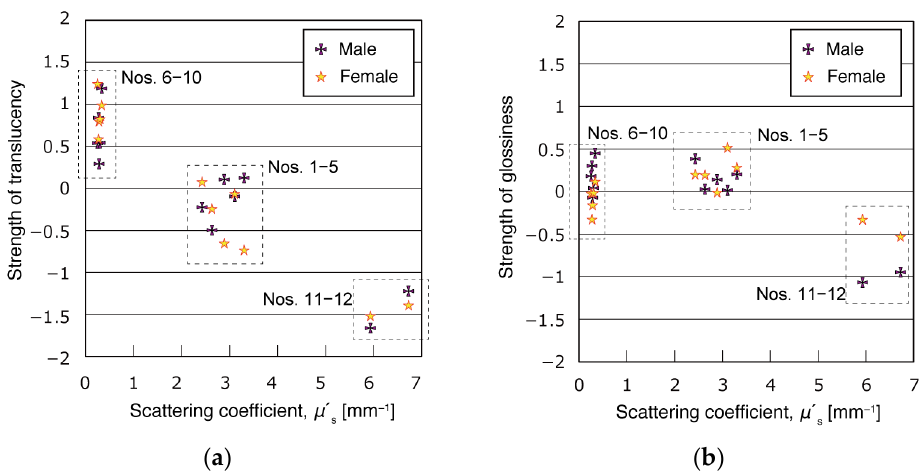
Figure 10. Comparison of results for sensory test between males and females: ( a ) translucency and ( b ) glossiness.